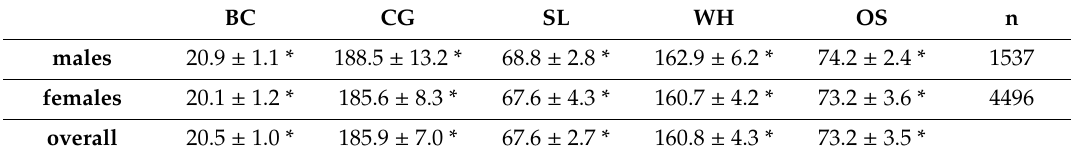
Table 1. Mean ± s.d. of body traits (cm) and overall score (out of 100).